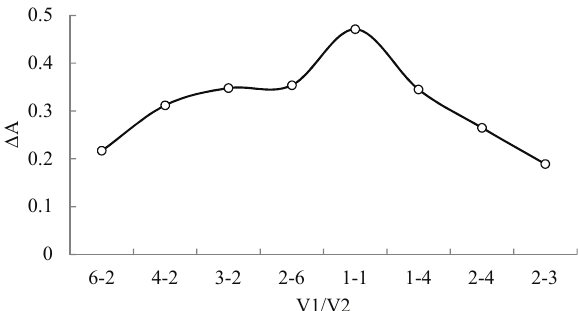
Fig. 4. Graph of the dependence of the amount of absorbance on the composition of the isomolar solution: V1 – 2.0×10 -4 M metoprolol tartrate solution; V2 – 2.0×10 -4 M solution BPB at 595 nm Fig. 2. Effect of solvents on the formation of metoprolol- BPB complex